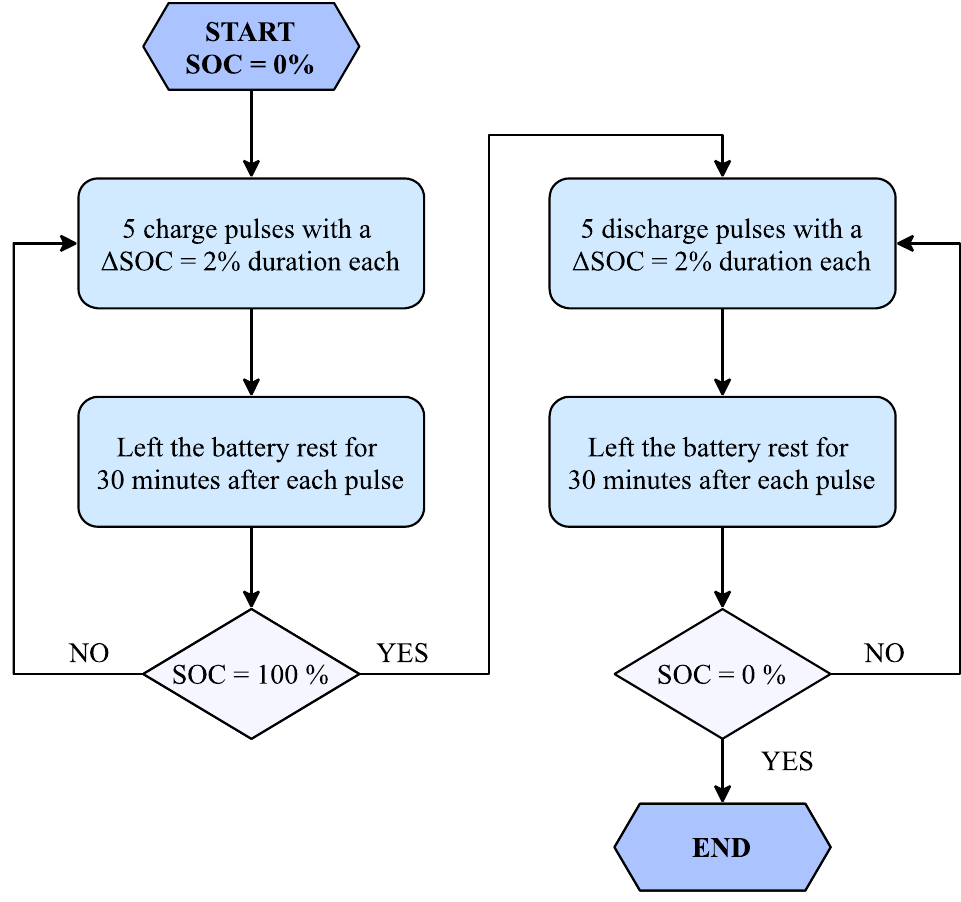
Figure 3. Implemented pulse test method procedure for the ECM parametrization.